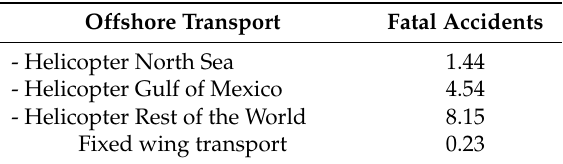
Table 2. Risk of fatalities from [3], per million-person flight